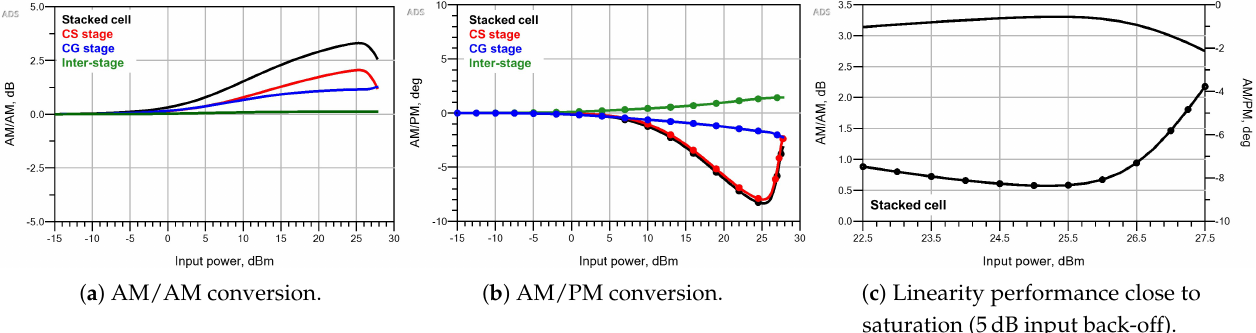
Figure 26. AM/AM (no symbols) and AM/PM (circles) simulations at 36GHz of the L GS -based cell and its